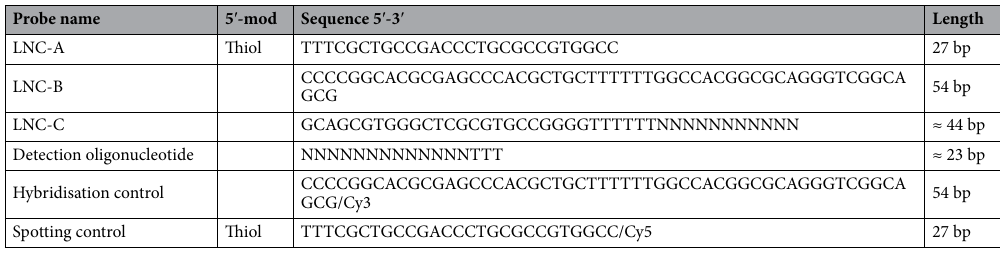
Table 1. Microarray probe sequences and